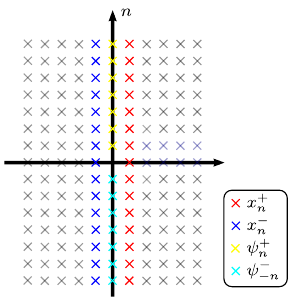
Figure 1 . DIM generators represented according to their degree ( x; y ) = ( (cid:22) d; (cid:0) d ) 2 Z (cid:10) Z